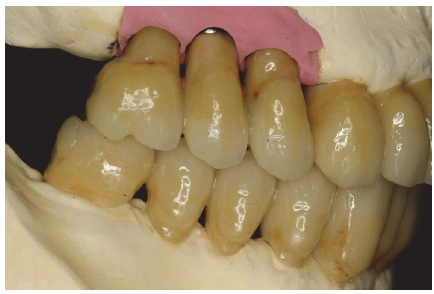
Figure 26: The impression copings used as temporary abutments were milled down according to the prosthetic need, and a second set of temporary restorations was fabricated.